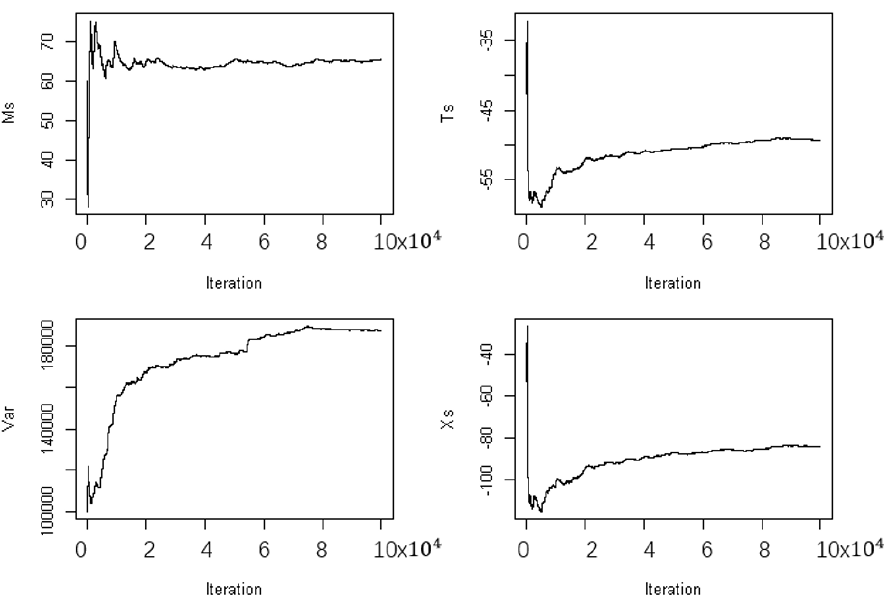
Figure 7. Running means of the source parameters (Run 1).